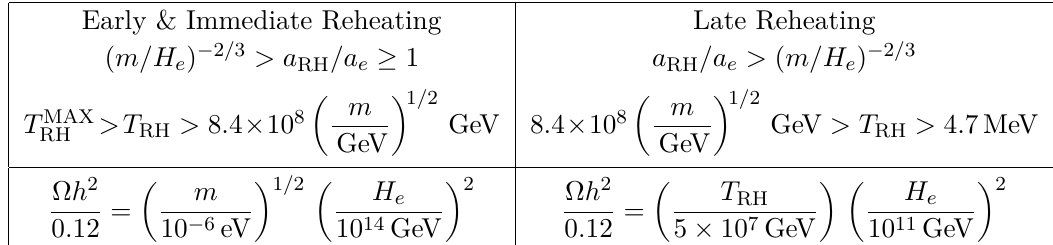
Table 1 . Results for Ω h 2 / 0 . 12 for immediate, early, and late reheating. The expression for T MAX is derived in the discussion before eq. (3.3). The lower limit to T RH is due to the requirement that the RD universe is able to produce the neutrino background